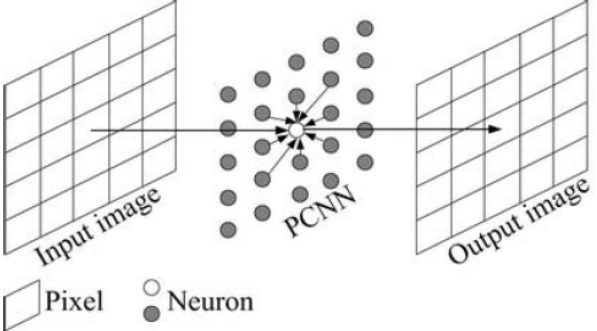
Figure 2. Representation of an image pyramid with four levels [89].